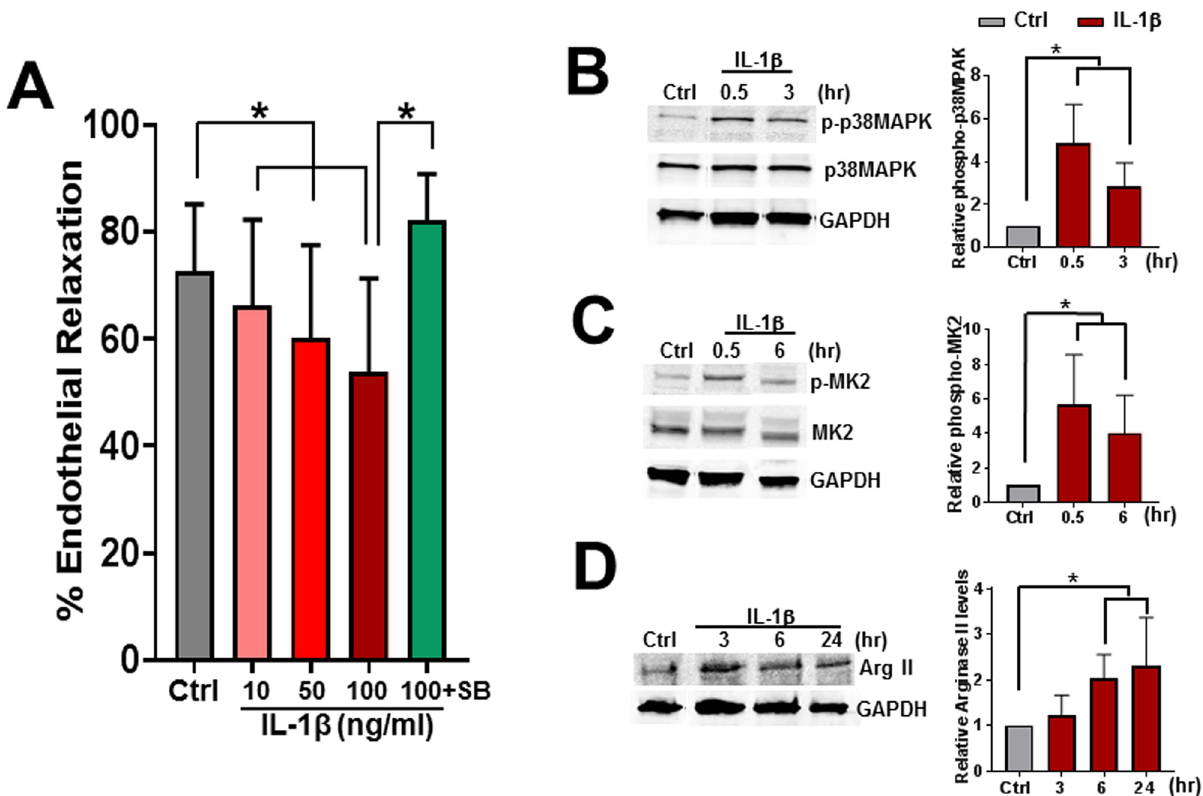
Fig 4. Treatment with IL-1 β impairs endothelial-dependent relaxation in rat aorta (RA), activates p38MAPK and MK2 and increases arginase II activity in HSVEC. ( A ) Rings of RA (n = 12–20 rats) were suspended in the muscle bath and left untreated (Ctrl), treated with IL-1 β (10, 50, and 100ng/ml), or co-treated with IL-1 β (100ng/ml) and SB203580 (20 μ M) for 3 hours. Tissues were pre-contracted with phenylephrine (5x10 − 7 M) and treated with carbachol (5x10 -7 M) and endothelial relaxation was measured, � p < 0.05, n = 12–20 rats. HSVEC were either untreated (Ctrl) or treated with IL1- β (10 ng/ml) for the times indicated. Cells were lysed, separated and immunoblots were probed for activated (phosphorylated, p-p38MAPK) or total p38MAPK ( B ), activated (phosphorylated p-MK2) or total MK2 ( C ), and arginase II (ArgII, D ). Representative immunoblots and cumulative data of relative phosphorylation compared to untreated cells shown. � p < 0.05, n =